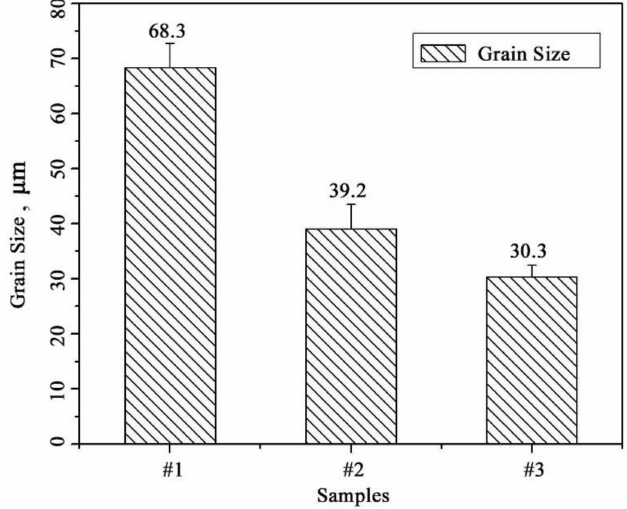
Figure 6. Measured CGHAZ austenite grain size of three